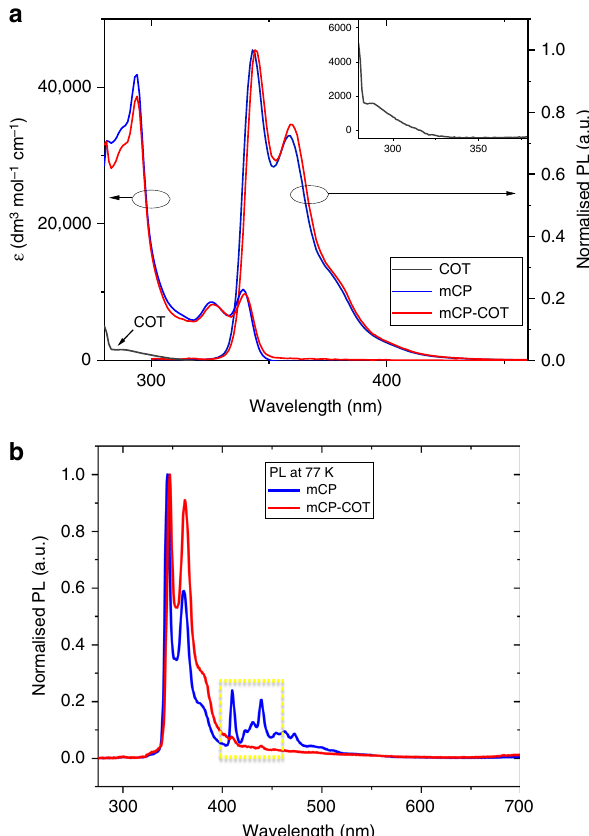
Fig. 2 Room- and low-temperature solution absorption and PL Spectra. a Solution absorption and normalised photoluminescence (PL, solid lines) spectra of COT*, mCP and mCP-COT in toluene (inset shows the weak COT absorption). Excitation wavelength = 290 nm. b Normalised photoluminescence of mCP (blue line) and mCP-COT (red line) at 77 K. At this low temperature, phosphorescence seen as peaks from 400 to 500 nm in mCP (yellow highlights) are not observed in mCP-COT, indicating ef fi cient quenching of the triplet excited-state of the mCP moiety within mCP-COT. Excitation wavelength = 300 nm. *no PL was observed for